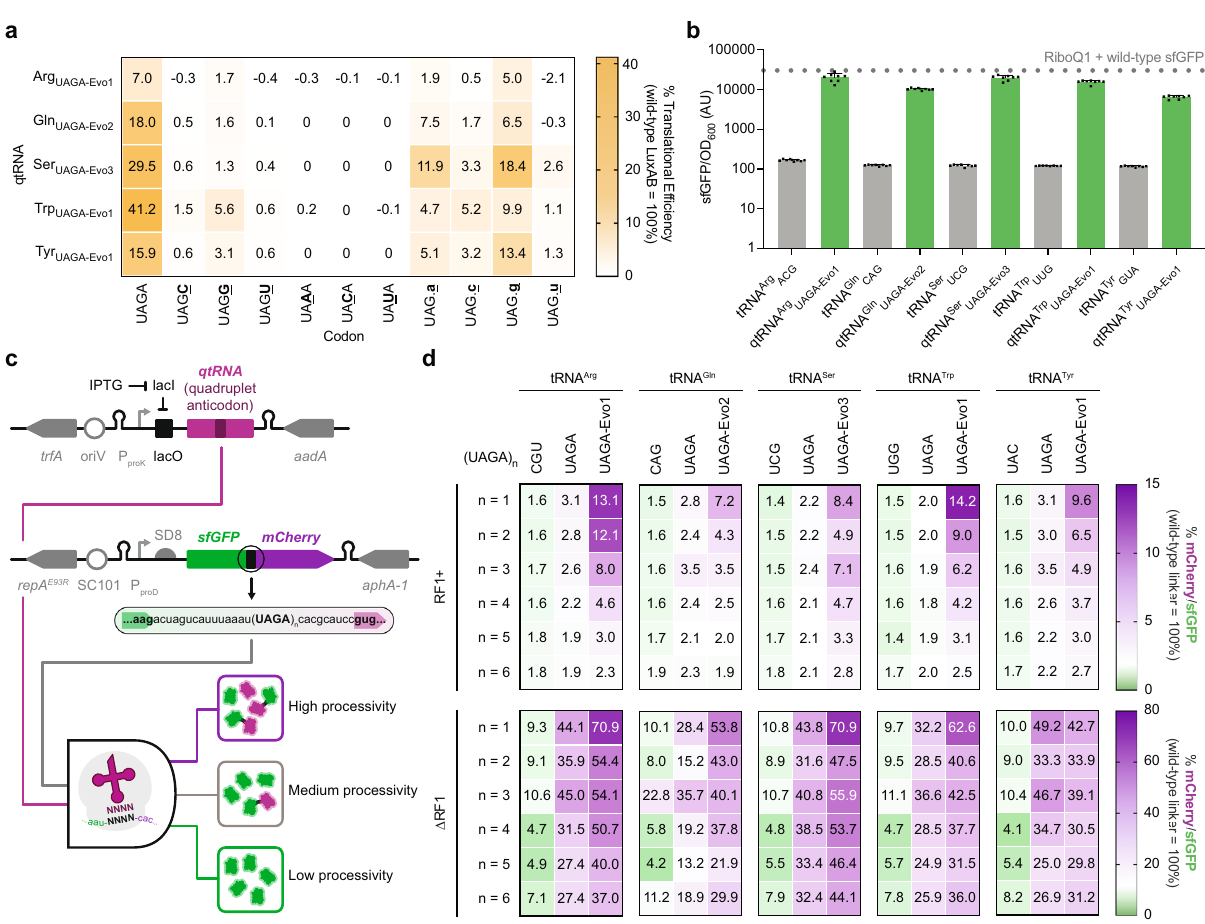
Fig. 4 Quanti fi cation of evolved qtRNA crosstalk and processivity. a Evolved UAGA-qtRNAs show moderate crosstalk with codons bearing a different nucleotide at the fourth position but not the third position of the quadruplet codon. Evolved UAGA-qtRNAs can additionally crosstalk with amber (UAG) codons, leading to a frameshift that is dependent on the base following the stop codon. In all cases, the activity of non-cognate codon-anticodon pairs is lower than the expected cognate interactions. b Quadruplet-codon translation using a previously described orthogonal ribosome RiboQ1 (contains mutations U531G, U534A, A1196G, A1197G in the 16S rRNA) 11 ( n = 8 biologically independent samples). c Schematic representation of the dual sfGFP- mCherry reporter assay to investigate the processivity of quadruplet codon translation. In all cases, sfGFP and mCherry are separated by a linker composed of adjacent UAGA quadruplet codons. The ratio of mCherry to sfGFP is a proxy for UAGA codon suppression ef fi ciency and processivity. d Evolved UAGA qtRNAs effectively translate linkers containing up to 5 − 6 adjacent UAGA quadruplet codons in the RF1 + strain S3489 (top) or the Δ RF1 strain JX33 (bottom). Although showing moderate ef fi ciencies, these tandem suppression events have been validated using mass spectrometry (wherever possible) and comprehensive peptide fragmentation spectra are reported in Supplementary Fig. 10, and summary LC-MS/MS results are reported in Supplementary Table 8. In all cases, reporter data is normalized to an otherwise wild-type protein and color-coded by the used reporter. Data represent the mean and standard deviation as